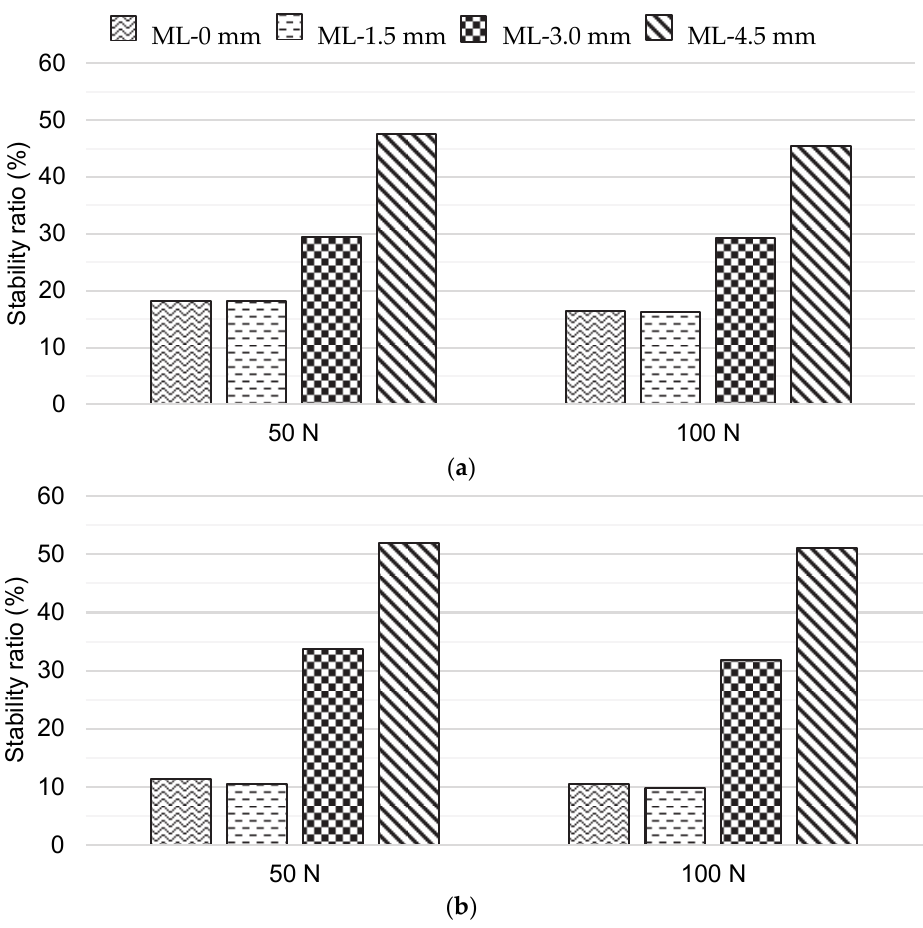
Figure 5. Stability ratios of the glenohumeral joint with a 20% glenoid bone defect after the Latarjet procedure for the medial–lateral graft positions modeled: ( a ) shoulder in 0 ◦ abduction in the scapular plane and in neutral rotation, and ( b ) shoulder in 60 ◦ abduction in the scapular plane with 45 ◦ of external